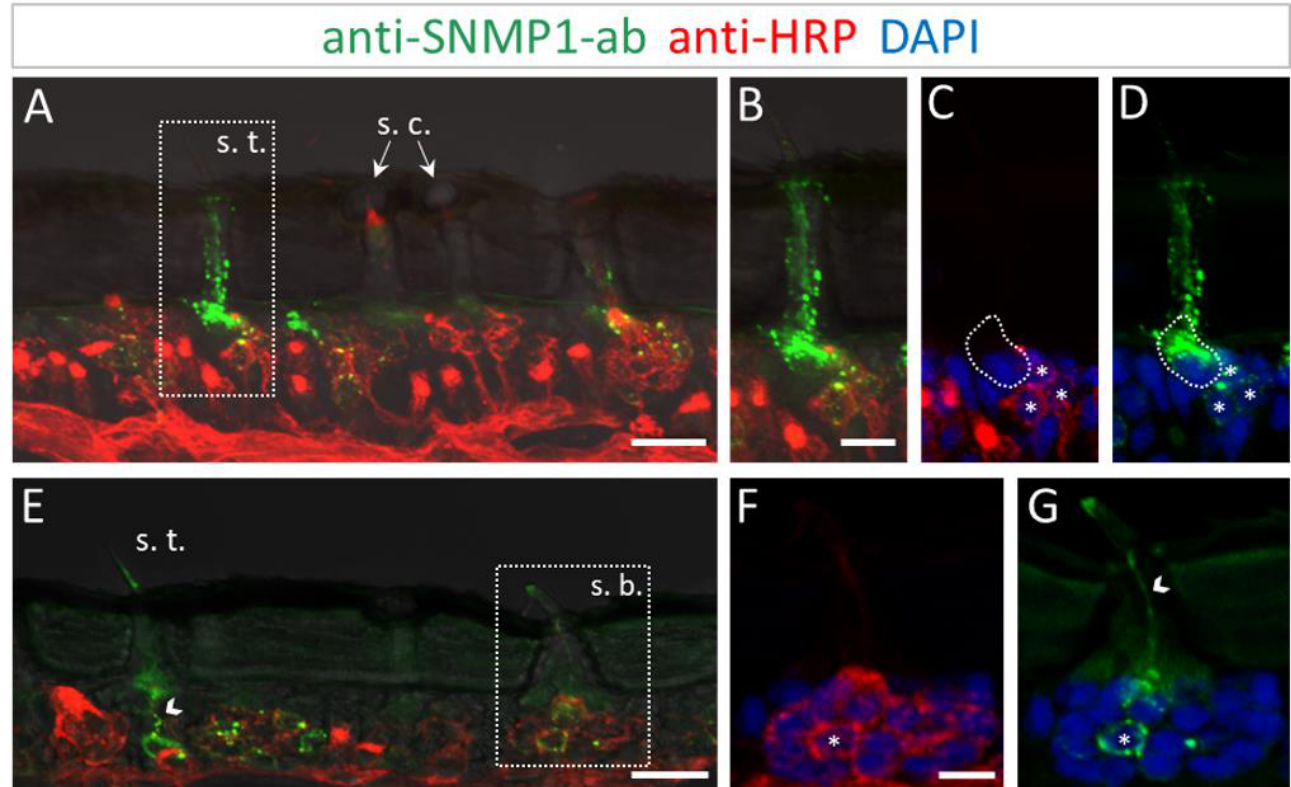
Figure 4. SNMP1 distribution in the antenna of L. migratoria. SNMP1-positive cells and neurons were visualized by FIHC on the longitudinal section using anti-SNMP1-ab (green) and anti-HRP-antibody (red), respectively. Nuclei were stained with DAPI (blue). ( A ) Shows that SNMP1 is localized in cells associated with the trichoid sensillum (s. t.). No labelling was found associated coeloconic sensilla (s. c.). ( B – D ) Displays the trichoid sensillum boxed in ( A ) in a higher magnification. ( B ) Green and red channels, ( C ) red and blue channels, and ( D ) green and blue channels. ( E ). Visualization of SNMP1-positive OSNs in trichoid and basiconic sensilla (s. b.). ( F , G ) Higher magnification of the basiconic sensillum boxed in ( E ) with ( F ) showing neuronal and ( G ) anti-SNMP1-ab labelling combined with nuclei staining. The asterisks denote SNMP1-positive neurons while the arrow heads indicate SNMP1-labelling of the dendrites. The encircled area indicates SNMP1 expression in a non-neuronal support cell. The transmitted light channel was overlaid with the fluorescent channels in ( A , B , E ). Scale bars: ( A , E ) = 20 µ m; ( B , F ) = 10 µ